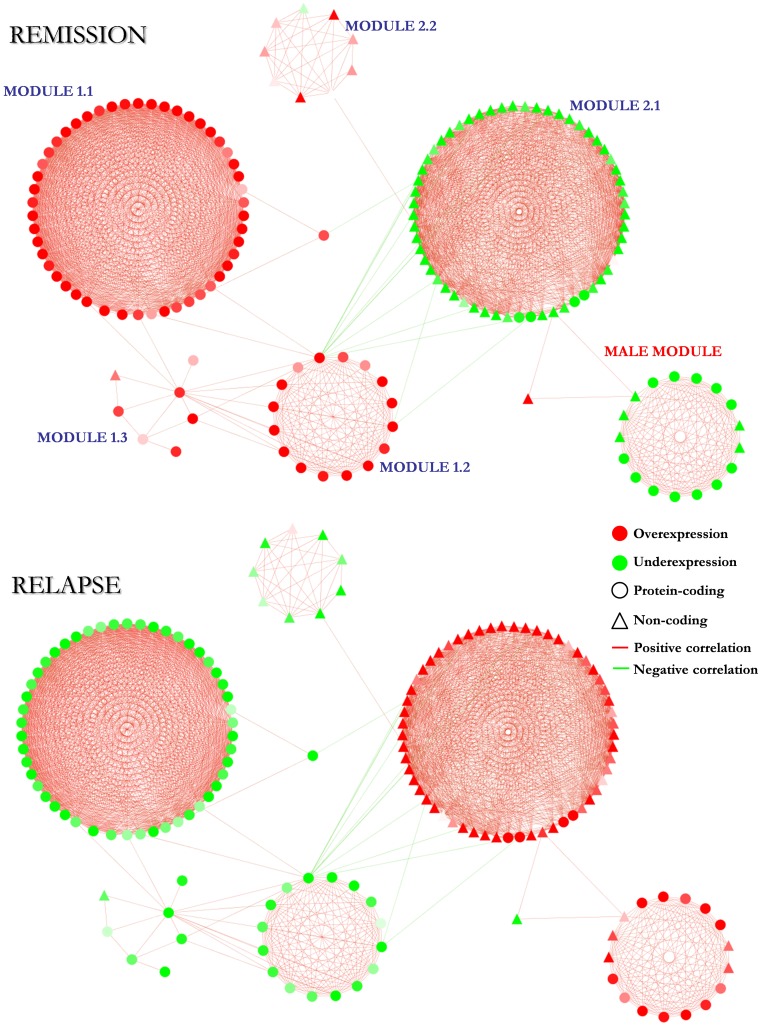
Main component of the coexpression network with the fold-changes obtained in remission and relapse.The color of the nodes codes for the differential expression of the genes (overexpression/underexpression), the node shapes for the type of gene (protein-coding/non-coding) and the color of the edges for the sign of the correlation (positive correlation/negative correlation).